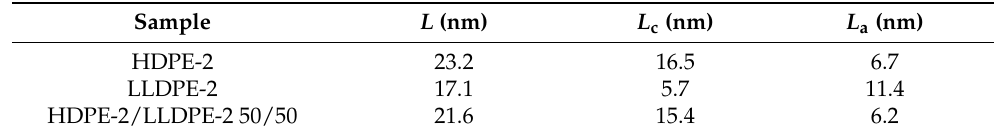
Figure 13. One-dimension correlation functions of the neat HDPE-2, LLDPE-2, and the HDPE- 2/LLDPE-2 50/50 blend. Table 9. Data of the long period ( L ), crystalline phase thickness ( L c ), and amorphous phase thickness ( L a ) obtained from the one-dimension correlation function.